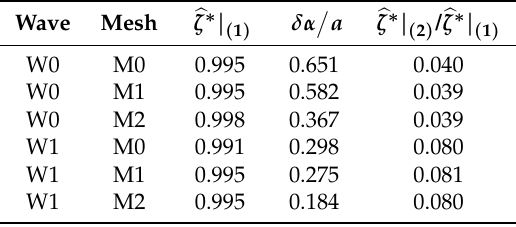
ζ ∗ is nondimensionalised b